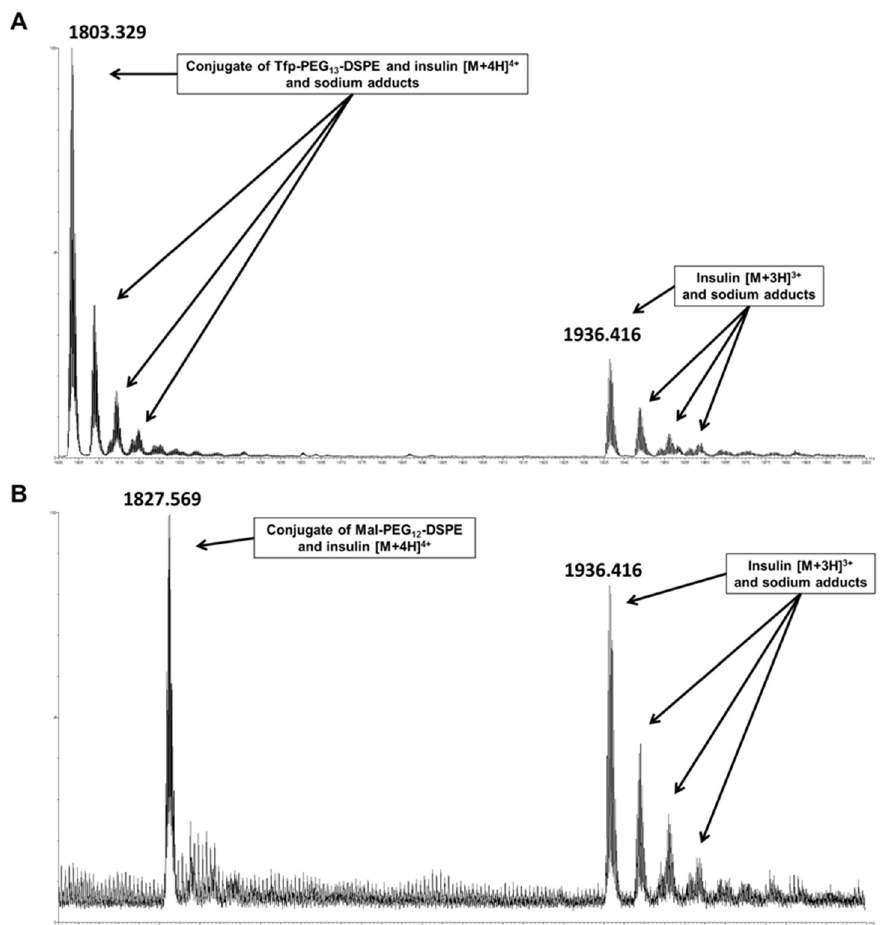
Figure 3. High-resolution mass spectra of liposomal formulations of insulin comprising lipids with maleimide and activated ester functions. ( A ) Liposomal formulation of insulin containing Tfp-PEG 13 -DSPE. Visible are the [M + 3H] 3+ ion of insulin with its sodium adducts and the [M + 4H] 4+ signal of the conjugate of insulin and Tfp-PEG 13 -DSPE with the corresponding sodium adducts. ( B ) Liposomal formulation containing Mal-PEG 12 -DSPE. Visible are the [M + 3H] 3+ signal of insulin with its sodium adducts and the [M + 4H] 4+ signal of the conjugate of insulin and Mal-PEG 12 -DSPE.